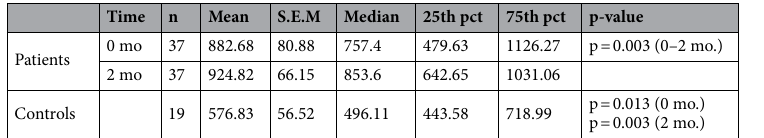
Table 2. Plasma uPAR levels. Plasma uPAR concentration in pg/ml pre-treatment (0 months) and 2-months post-treatment. Percentile